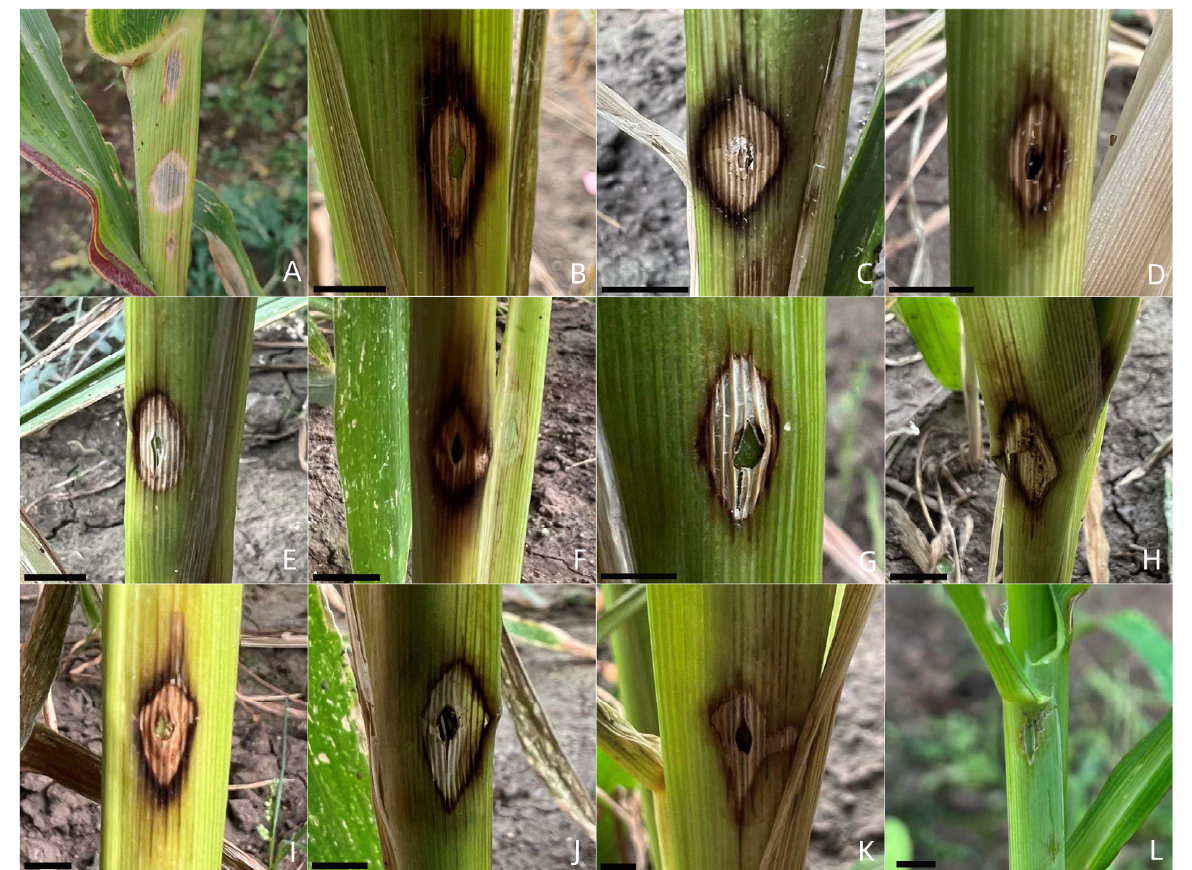
Figure 5. Inoculation of maize leaf sheaths with different Fusarium species (var. Zhengdan 958). ( A ) Maize sheath rot symptoms observed in the field; ( B – K ) typical symptoms on maize sheaths caused by F. verticillioides , F. subglutinans , Fusarium incarnatum-equiseti species complex, F. temperatum , F. acuminatum , F. solani , F. sporotrichioides , F. tricinctum , F. asiaticum , and F. proliferatum , respectively; ( L ) CK. Bar = 5 mm.